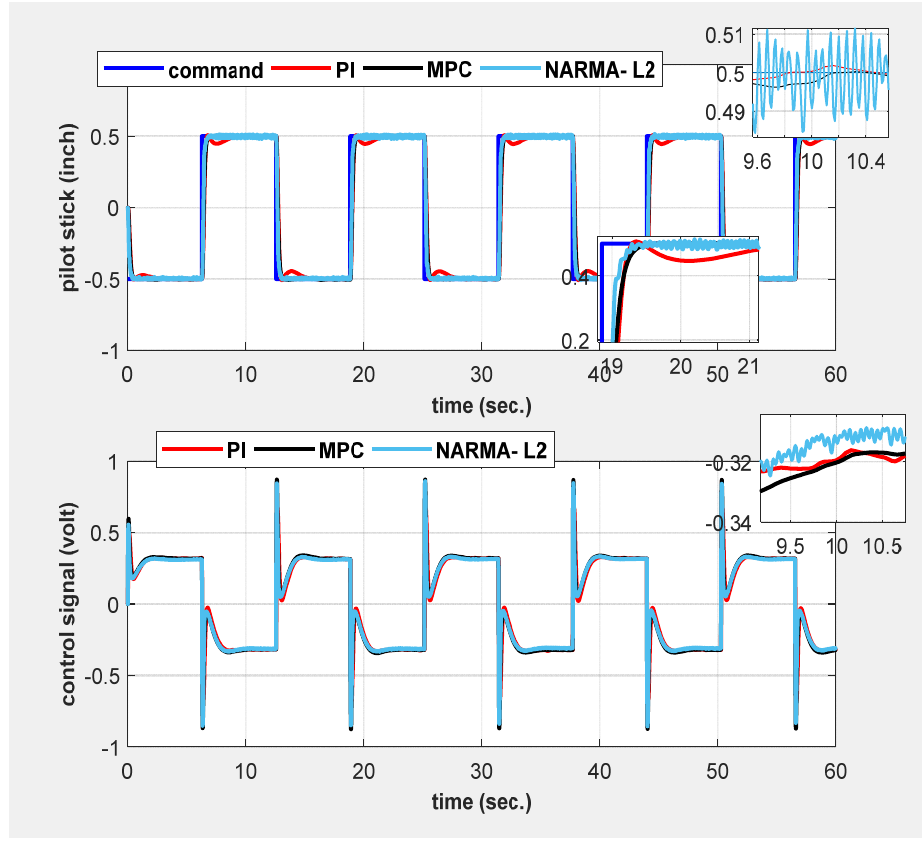
Mathematics 2022 , 10 , x FOR PEER REVIEW Figure 18. Pilot stick square wave response with corresponding error. Figure 18. Pilot stick square wave response with corresponding error.